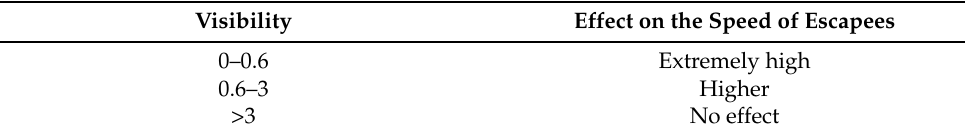
Table 6. The effect of the smoke visibility on the human